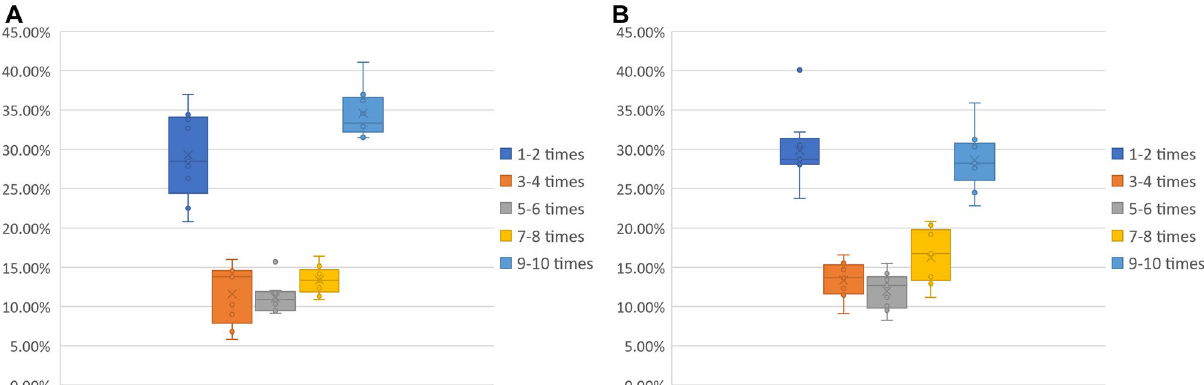
Figure 4. The distribution of input nodes repeatedly identified over 10 iterations of the genetic algorithm for the biological networks. For each biological network we counted how many of the input nodes were found in at least 9–10/7–8/5–6/3–4/1–2 of the 10 runs we did on that network. The box plots show the distribution of these counts over all the biological networks. ( A ) Repeated (stochastic) runs over the biological networks. ( B ) Repeated runs over the biological networks with of their 5% edges randomly